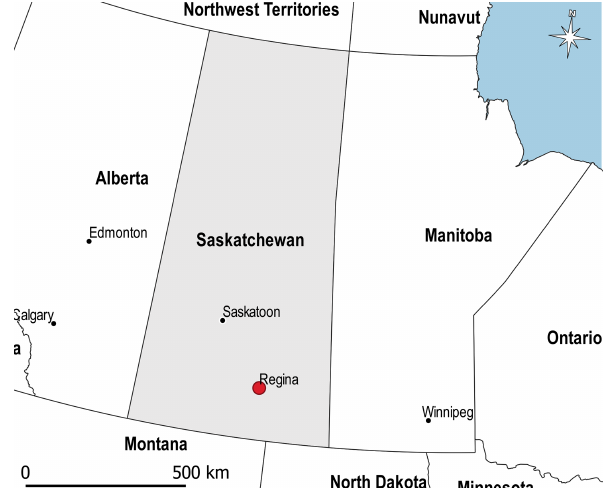
Figure 2. Test site location (red) in Canada. Province of Saskatchewan shown shaded.